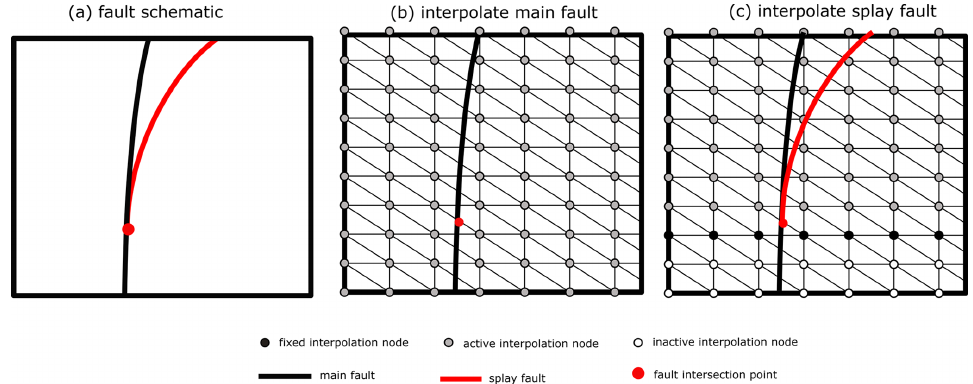
Figure 5. Schematic diagram showing interpolation of splay faults. (a) Fault diagram showing the observations of the main fault (blue dots) and splay fault (red dot). The splay region is represented by the rectangle with the diagonal lines) (b) Interpolation support for main fault showing fault geometry and all interpolation nodes being active. (c) Interpolation of splay fault showing fixed, active and inactive interpolation nodes where the fault geometry is shared.